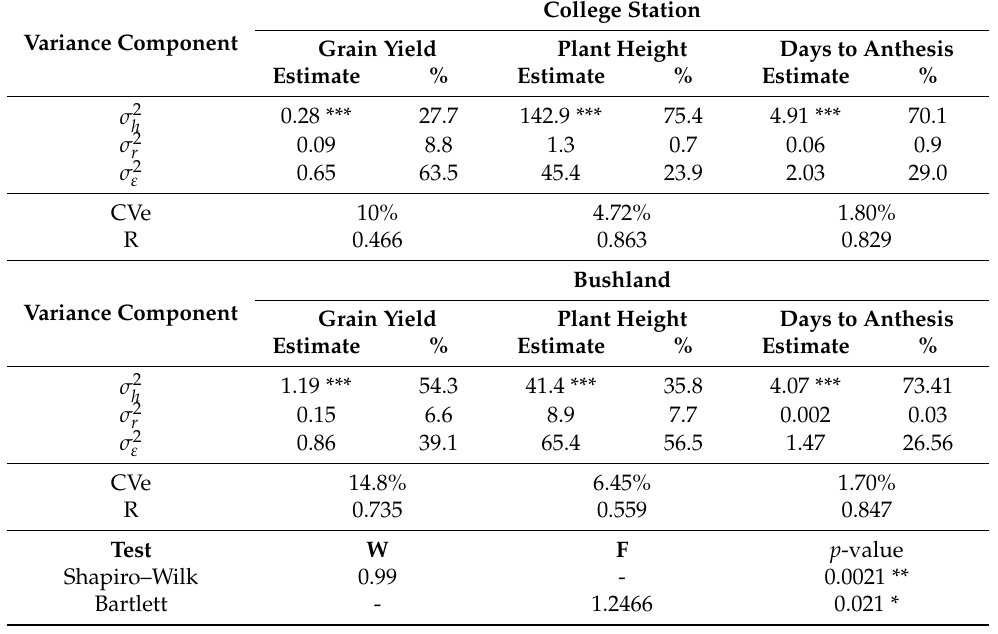
Table 1. Variance components, repeatability (R), and coefficient of variation (CVe) estimates derived from single environment analysis of grain yield, plant height, and days to anthesis. The percent of total variation (%) for hybrids, replicate, and residual are shown with their respective estimates. Wald p -value was used to indicate significance of effects. Shapiro–Wilk (W) and Bartlett test (F-test) followed by their corresponding p -values are presented. *, **, and *** represent significance at the 0.05, 0.01, and 0.001 level,